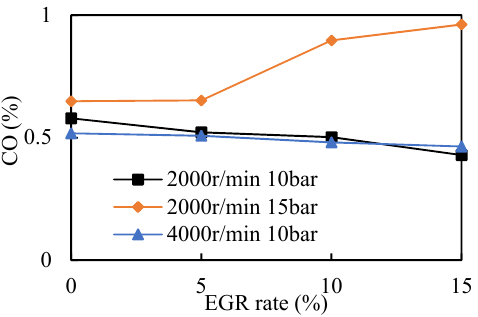
Figure 13. CO emission characteristics under different EGR rates.